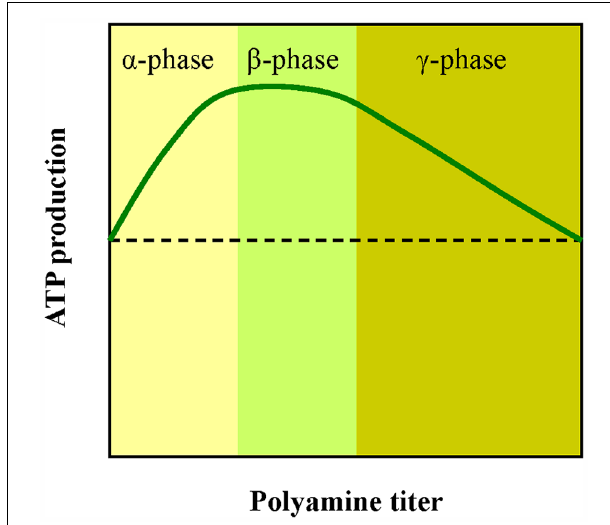
FIGURE 4 |A simplified scheme showing the effect of PAs onATP production by thylakoids. Low doses of PAs stimulate photophosphorylation ( α phase). Higher doses lead to reduction of ATP synthesis ( γ phase).The x axis is qualitative because in all three PAs (Put, Spd, and Spm) the peak value corresponds to different concentration although the shape of the curve is